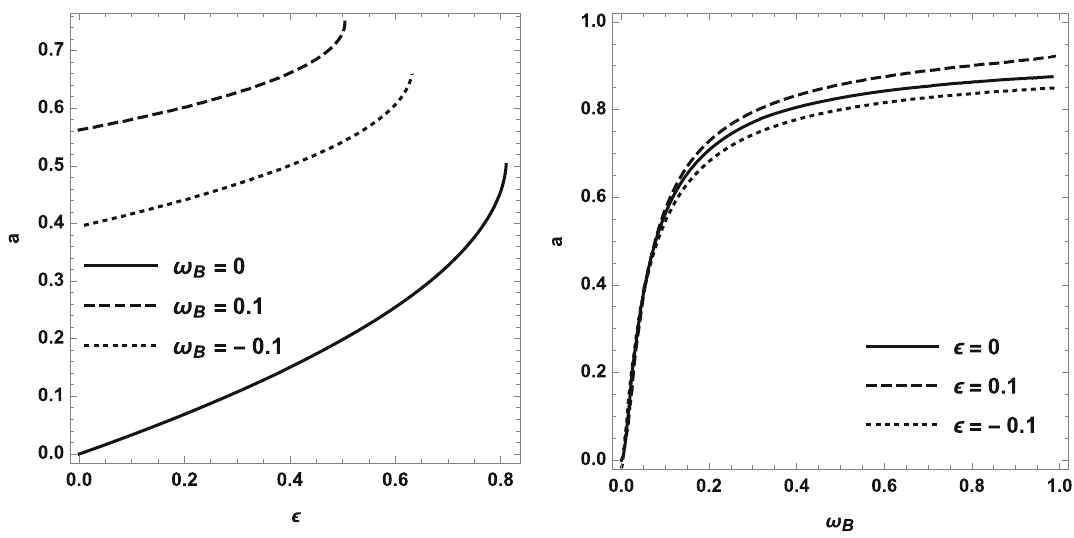
Fig. 4 Degeneracy plot that shows the correspondence between of the dimensionless rotation parameter a of a Kerr metric with (cid:2) and B